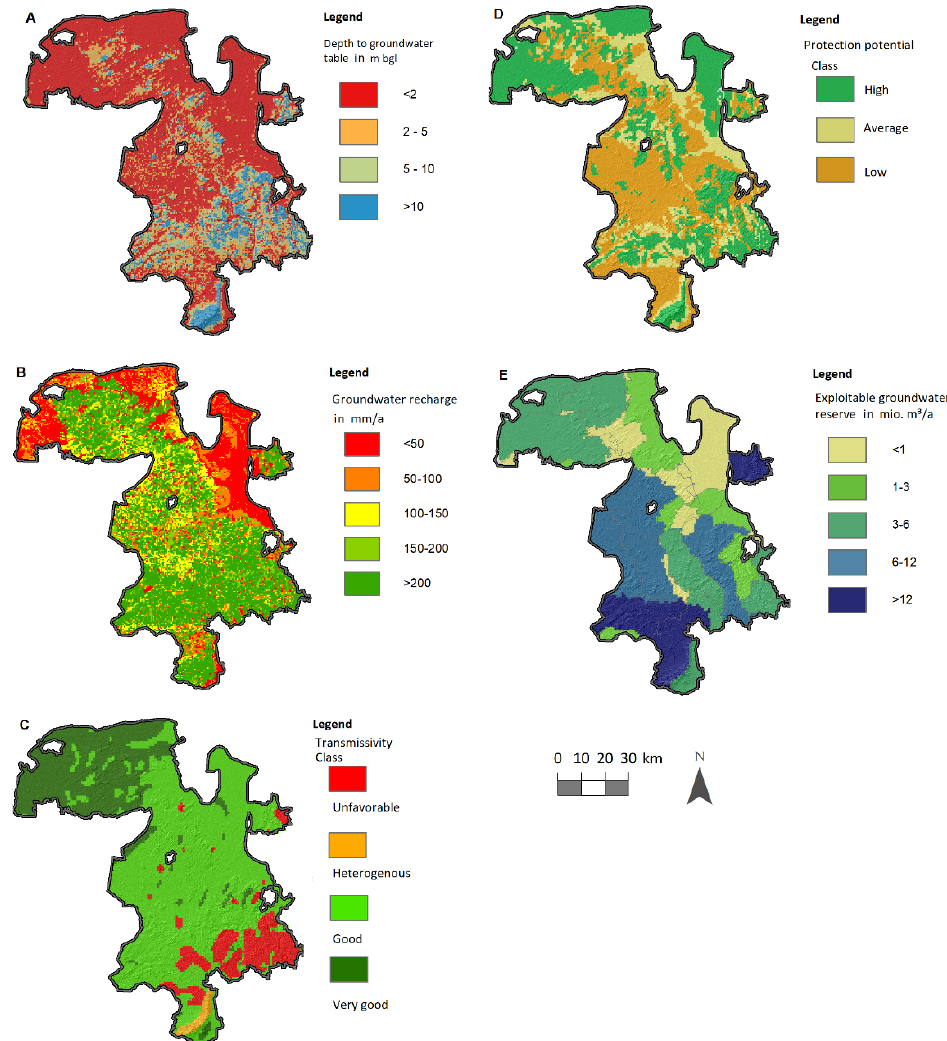
Figure 3. Raster data sets used as rating criteria: ( A ) groundwater hydraulic heads based on [58], ( B ) mean annual groundwater recharge from 1980 to 2010 [59,60], ( C ) hydrogeological abstraction conditions [61], ( D ) groundwater protection potential [62], and ( E ) exploitable groundwater reserve per groundwater sub-body [63].